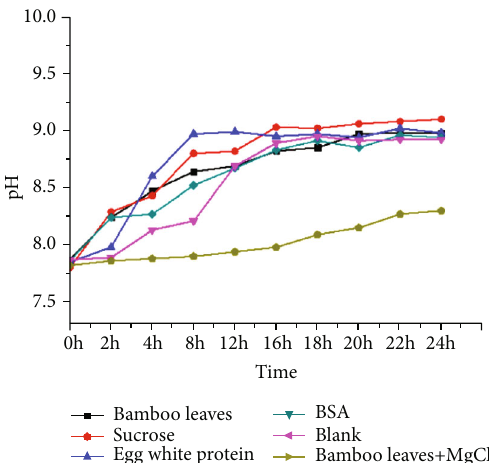
Figure 8: Change chart of calcium ion